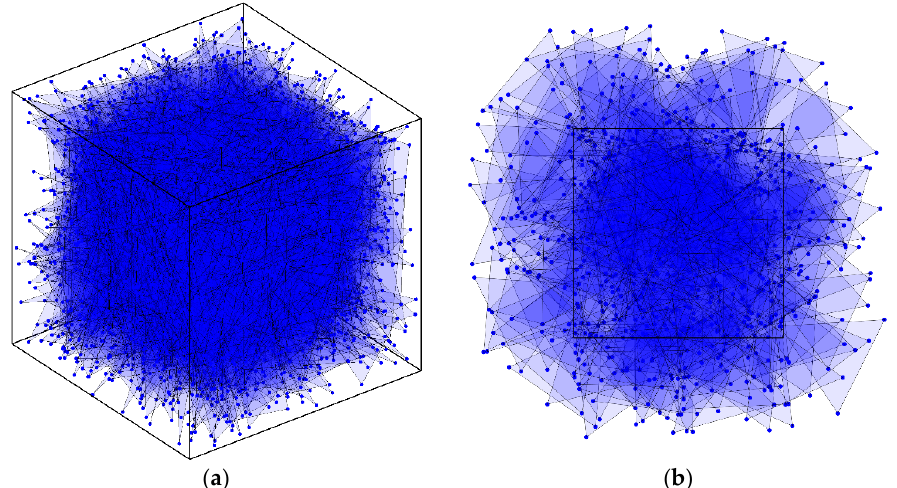
Figure 2. Examples of inaccurate sampling: ( a ) Sampling triangles are selected when all end points end in the container (boundary effect); ( b ) End points are randomly generated in the space, exceeding the system (2D illustration for a clear view).